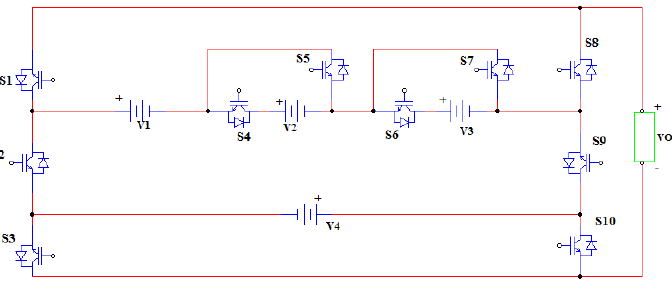
Figure 4. Ten-switch, nine-level topology [53].